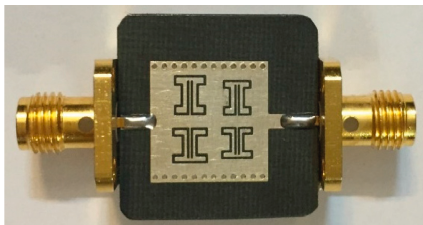
Figure 17: Image of the fabricated quad-band bandpass filter [9].